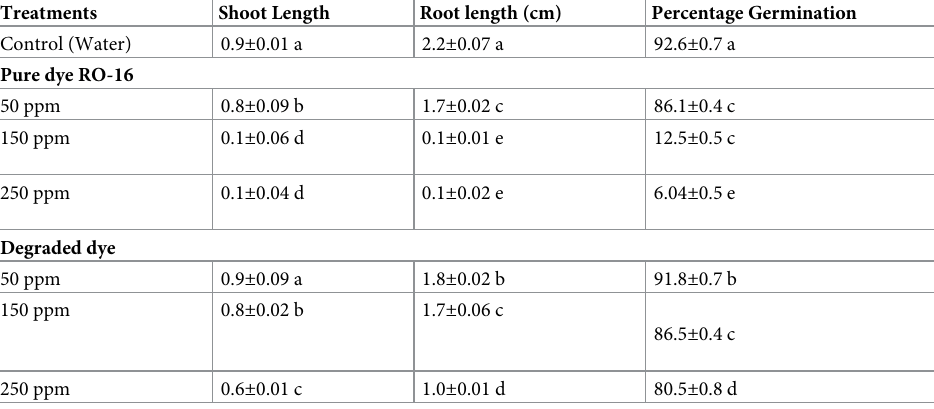
Table 2. Phytotoxicity comparison of Reactive orange 16 and its extracted metabolites.